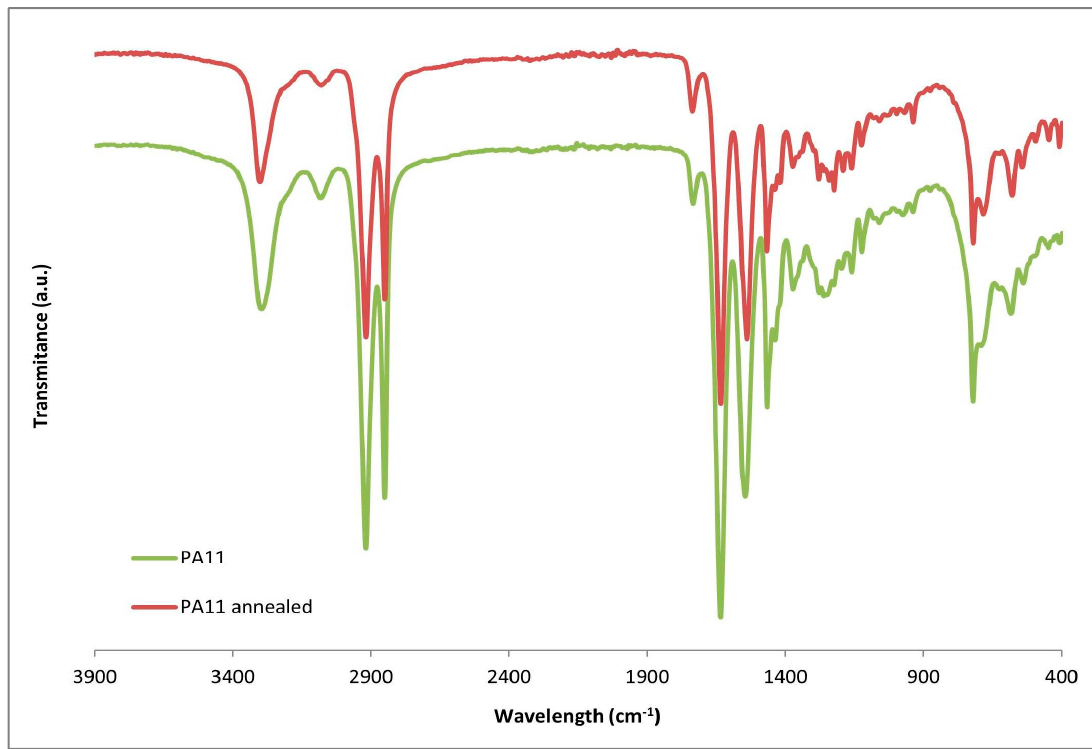
Figure 12. FT-IR of PA11 and annealed PA11.